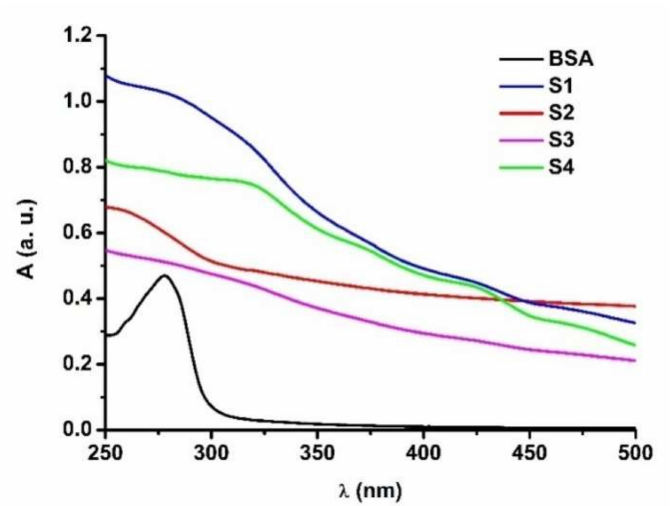
Figure 4. The absorbance of BSA (3 µ M) and of S1–S4 (3 µ M) samples at pH 7.45. Samples were studied in 100 mM HEPES buffer, at room